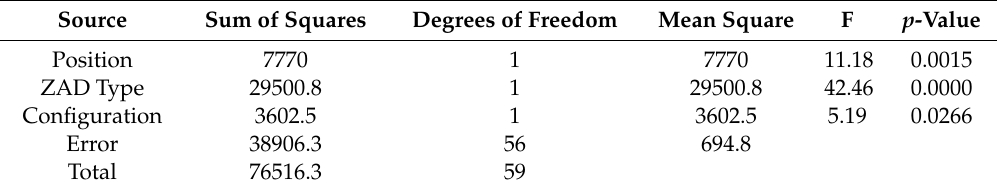
Table 7. ANOVA for geotextile B results.